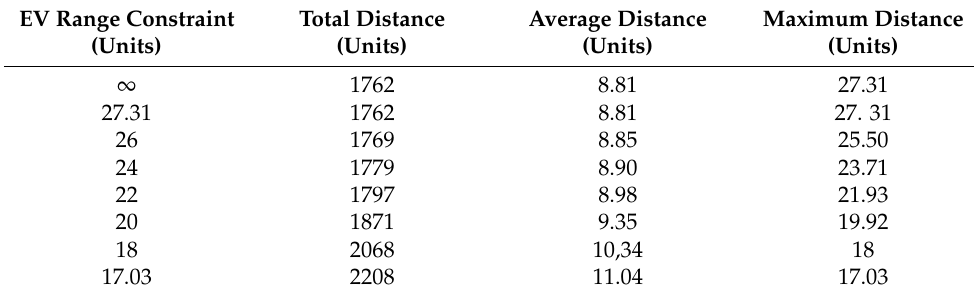
Table 3. Optimization results for di ff erent EV traveling range constraints.